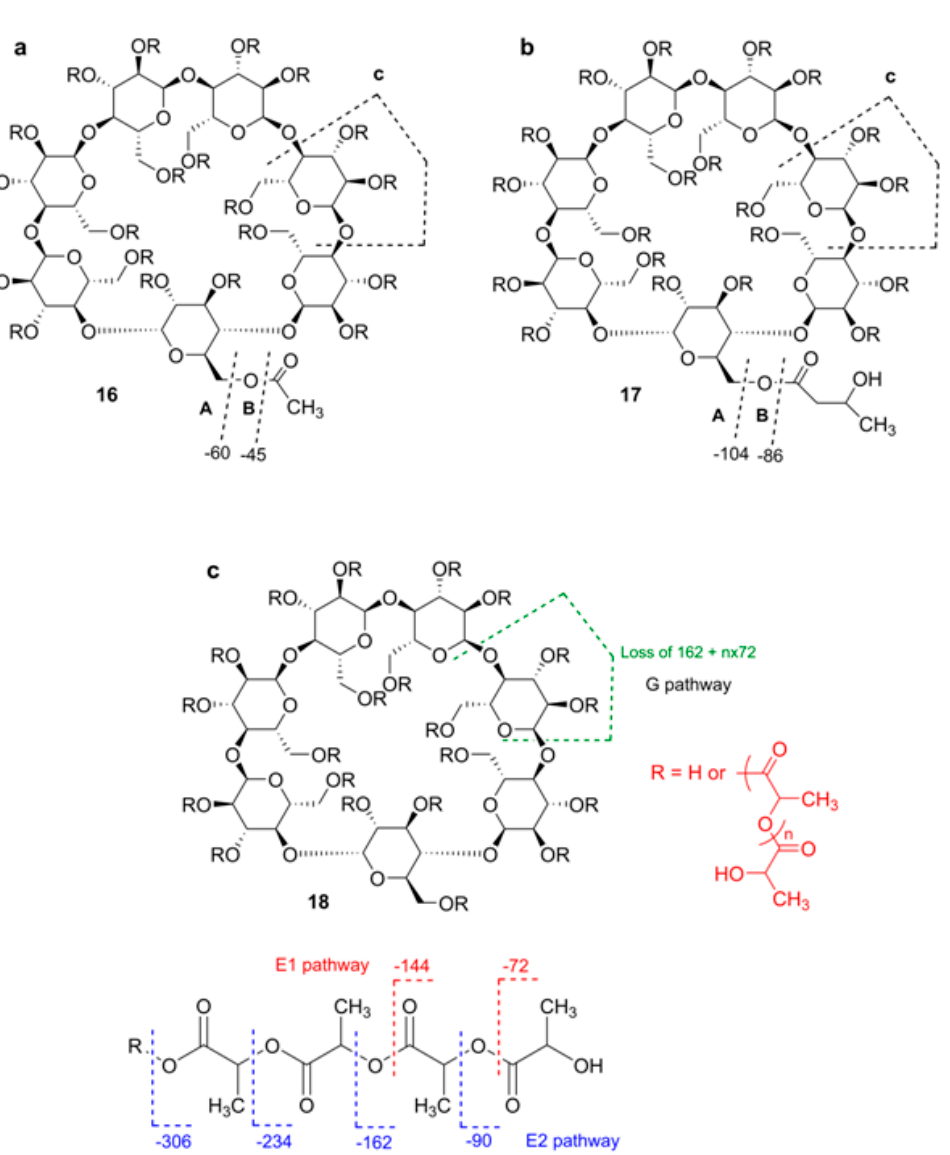
Figure 15. Fragmentation of acylated β -CDs according to Peptu et al. ( a ) totally acetylated, TABCD [65]; ( b ) randomly 3-hydroxybutyrated, HBCD [65]; ( c ) oligolactate [66]. (Open Access material under